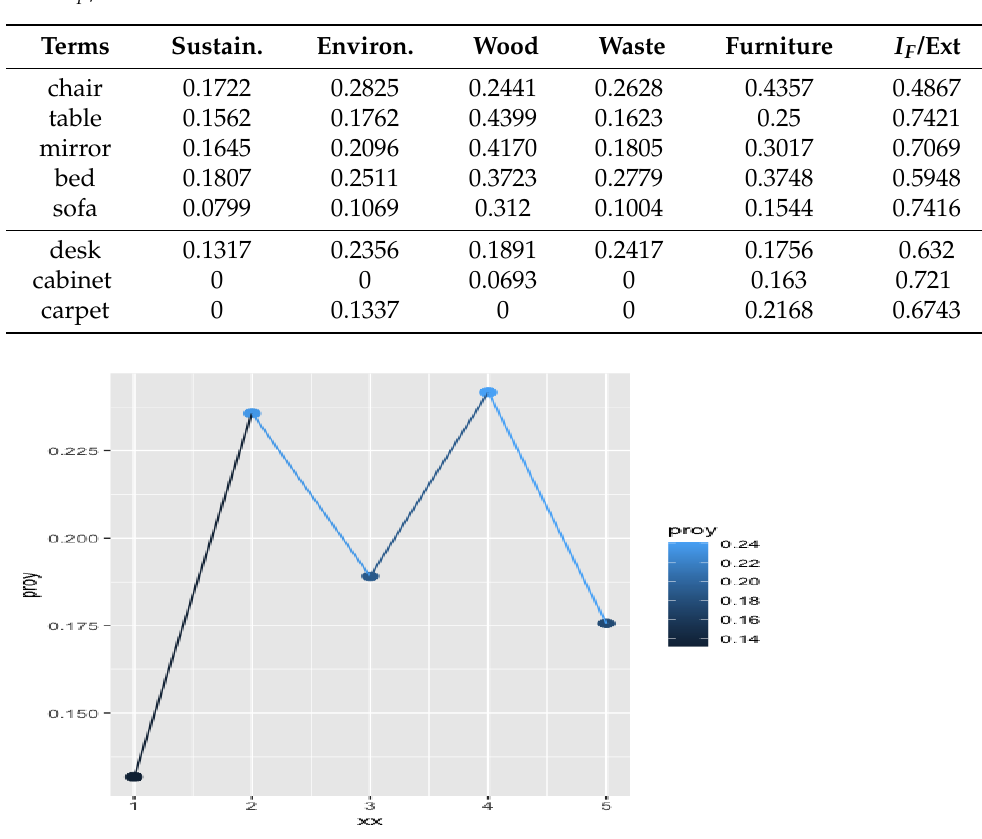
Table 4. Projections for the terms considered, together with the corresponding values of the (extended) index I F / Ext .